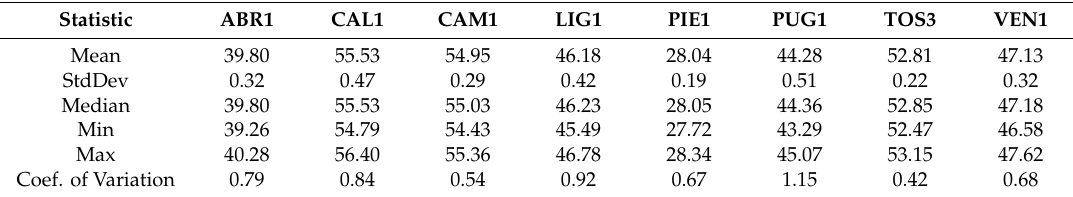
Table 2. Summary statistics of diameter at breast height (cm) from dendrometers over the 2009–2013 time period, by